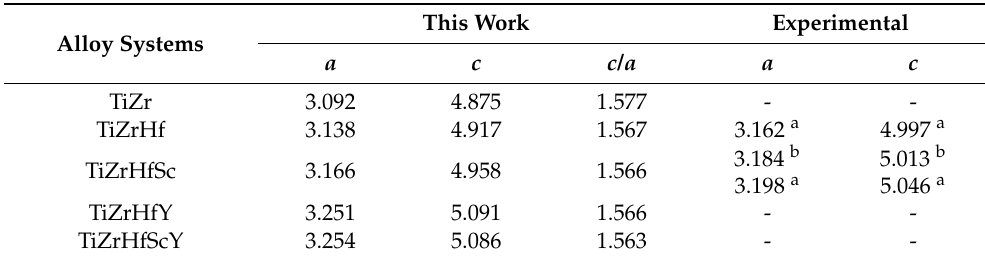
Table 1. Lattice parameters a and c of CSAs obtained from the first-principles calculations (this work) and experimental studies